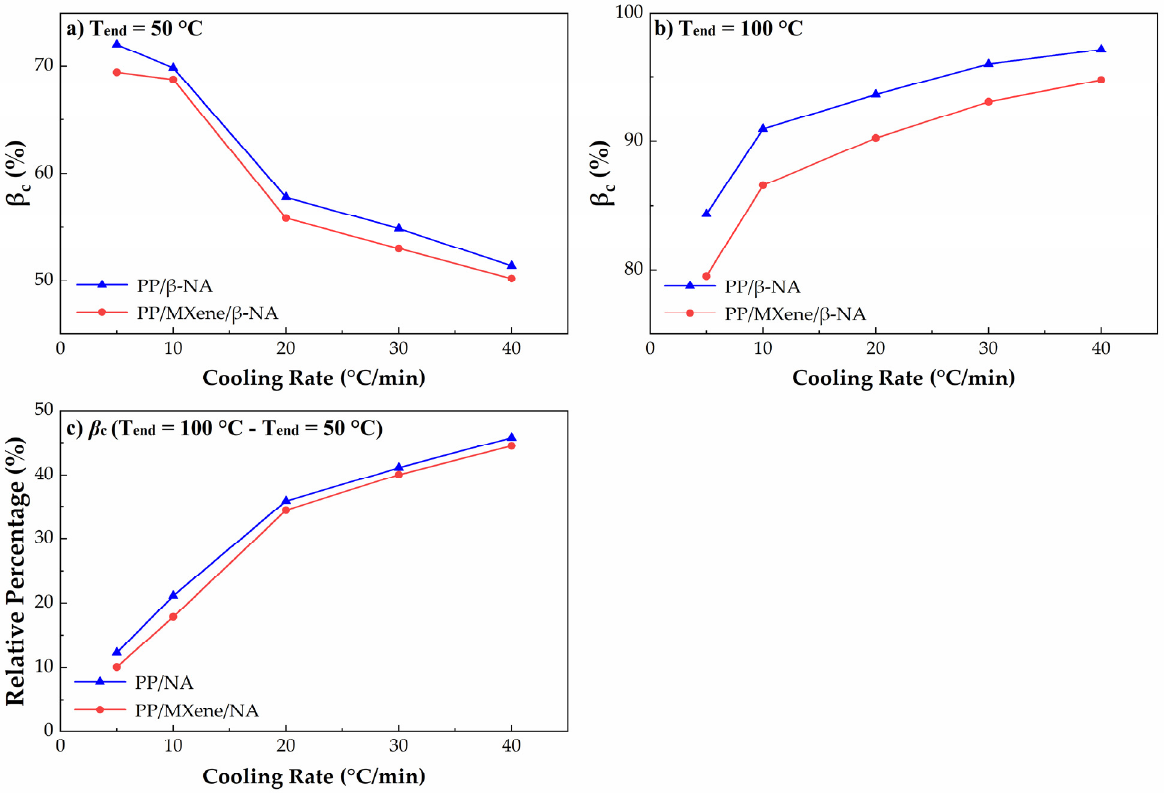
Figure 11. Plots of relative percentage crystallinity of β phase at ( a ) T end = 50 °C, ( b ) T end = 100 °C, and ( c ) their differences β c (T end = 100 °C—T end = 50 °C) at 5, 10, 20, 30, and 40 °C/min.